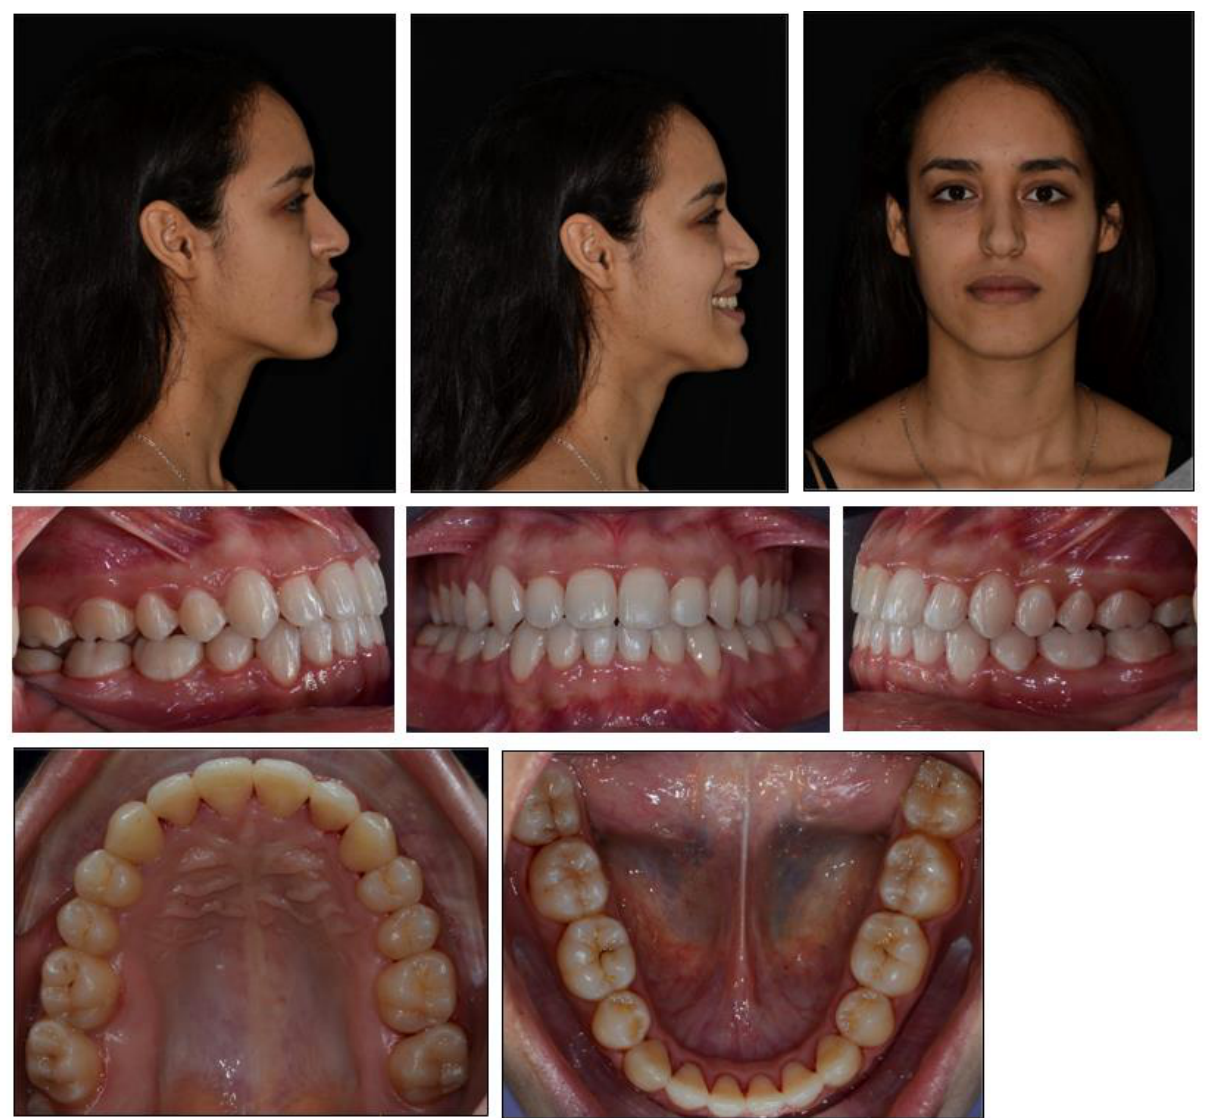
Figure 6. Final extraoral and intraoral views. Figure 7. Final extraoral and intraoral